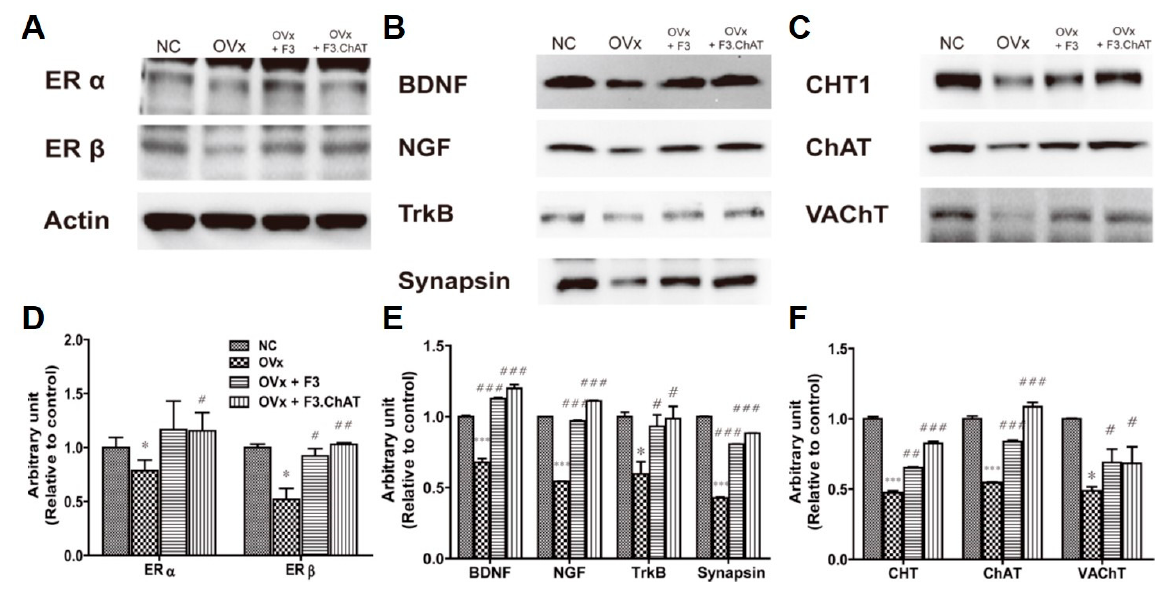
Figure 8. Expression of ER α and β ( A ), proteins related to the neurotrophin pathway ( B ), and the cholinergic system ( C ) in ovariectomized rats four weeks after transplantation of F3 or F3.ChAT cells. ( A – C ) Representative bands of ER α and β ( A ), proteins related to the neurotrophin pathway ( B ), and the cholinergic system ( C ). ( D – F ) The band densities were normalized to that of actin. * Significantly different from the normal control ( p < 0.05). *** Significantly different from the normal control ( p < 0.001). # Significantly different from the OVx ( p < 0.05) group. ## Significantly different from the OVx ( p < 0.05) group. ### Significantly different from the OVx ( p < 0.05) group.